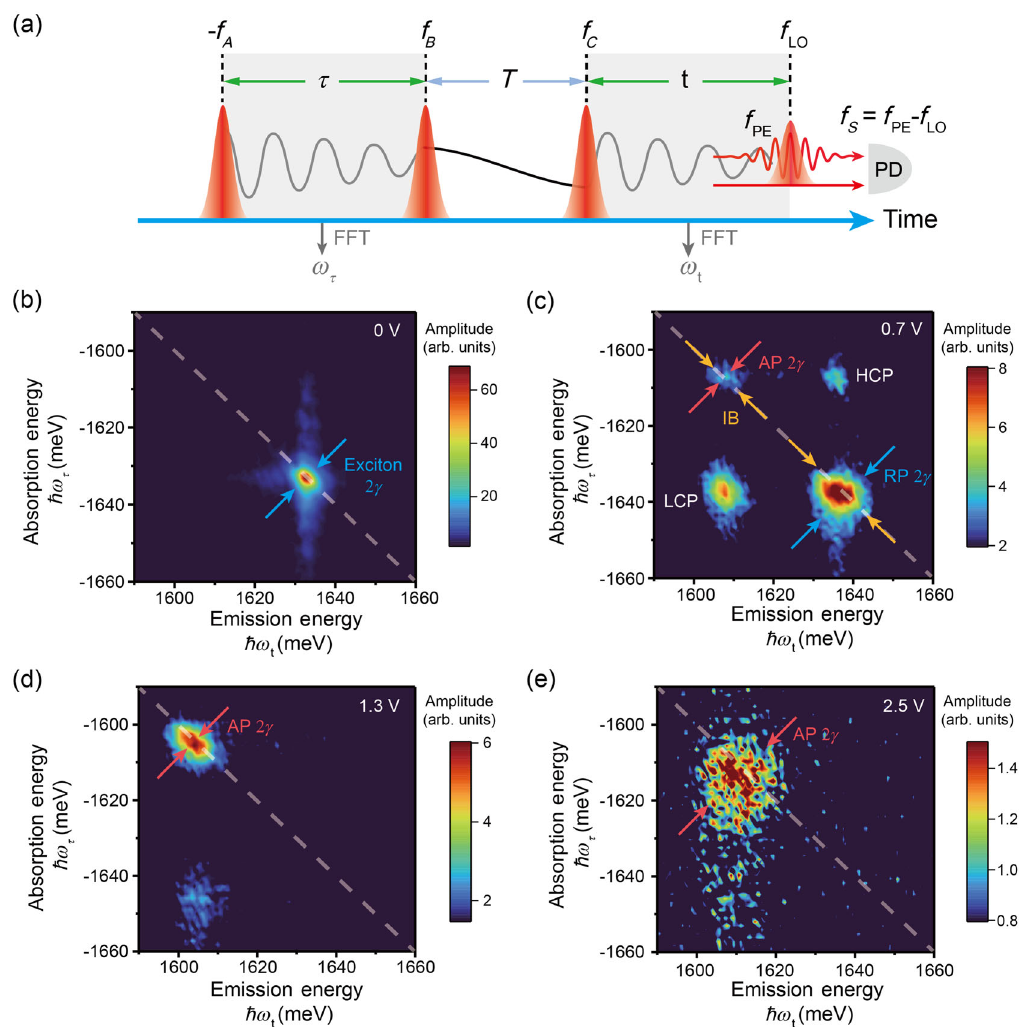
FIG. 2. One-quantum rephasing amplitude spectra of the MoSe 2 monolayer at different gate voltages. (a) Schematic of the one- quantum rephasing pulse sequence. Details are further discussed in the Supplemental Material [21]. (b) – (e) 2D spectra taken at different top-gate voltages at 0, 0.7, 1.3, and 2.5 V, respectively. These gate voltages correspond to estimated electron doping densities of ¼ 0 ; 6 . 6 × 10 11 ; 2 . 6 × 10 12 , and 6 . 6 × 10 12 e − = cm 2 . IB, inhomogeneous broadening; HCP and LCP, higher and lower off-diagonal n e − cross peak. Homogeneous (inhomogeneous) linewidth of exciton, AP, and RP could be extracted by fitting the cross-diagonal (diagonal) slices of the spectra, as illustrated by the arrows in blue (exciton and RP) and red (AP)